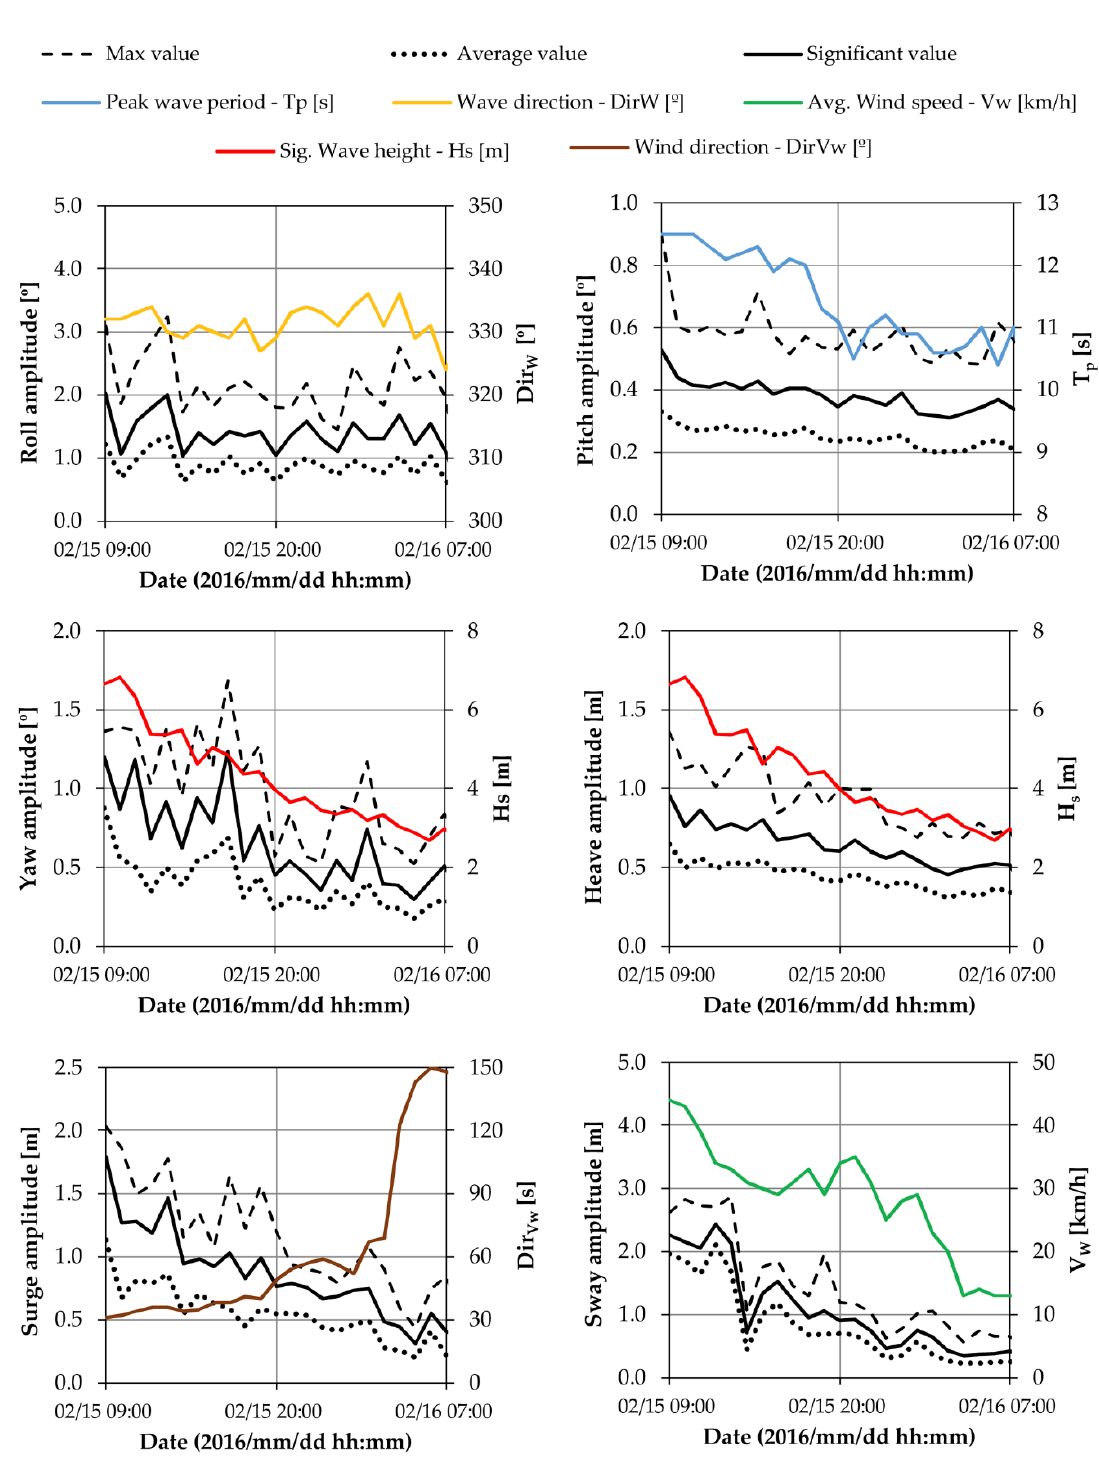
Figure 5. Maximum, average and significant amplitudes of each motion recorded during the WESTERN BOHEME bulk carrier vessel’s stay in port and its concomitant climatic forcings.